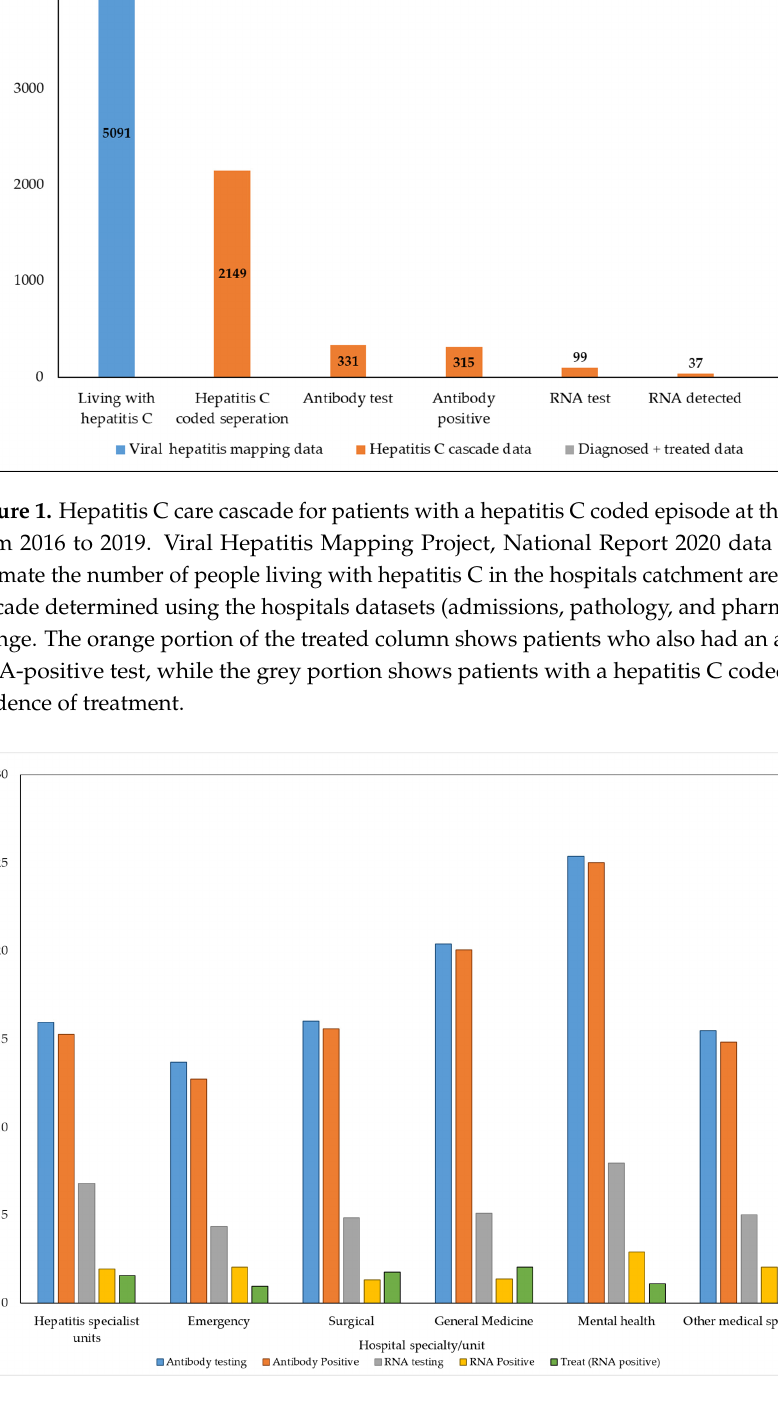
Figure 2. Hepatitis C care cascade for the Alfred Hospital 2016–2019 by specialty unit. The denomi- nator ( n ) for all steps in the cascade is the patients with hepatitis C coded admissions in that specialty (Table 2). Treated includes patients who had a positive antibody or RNA test. Table 2. The hepatitis C care cascade by specialty.